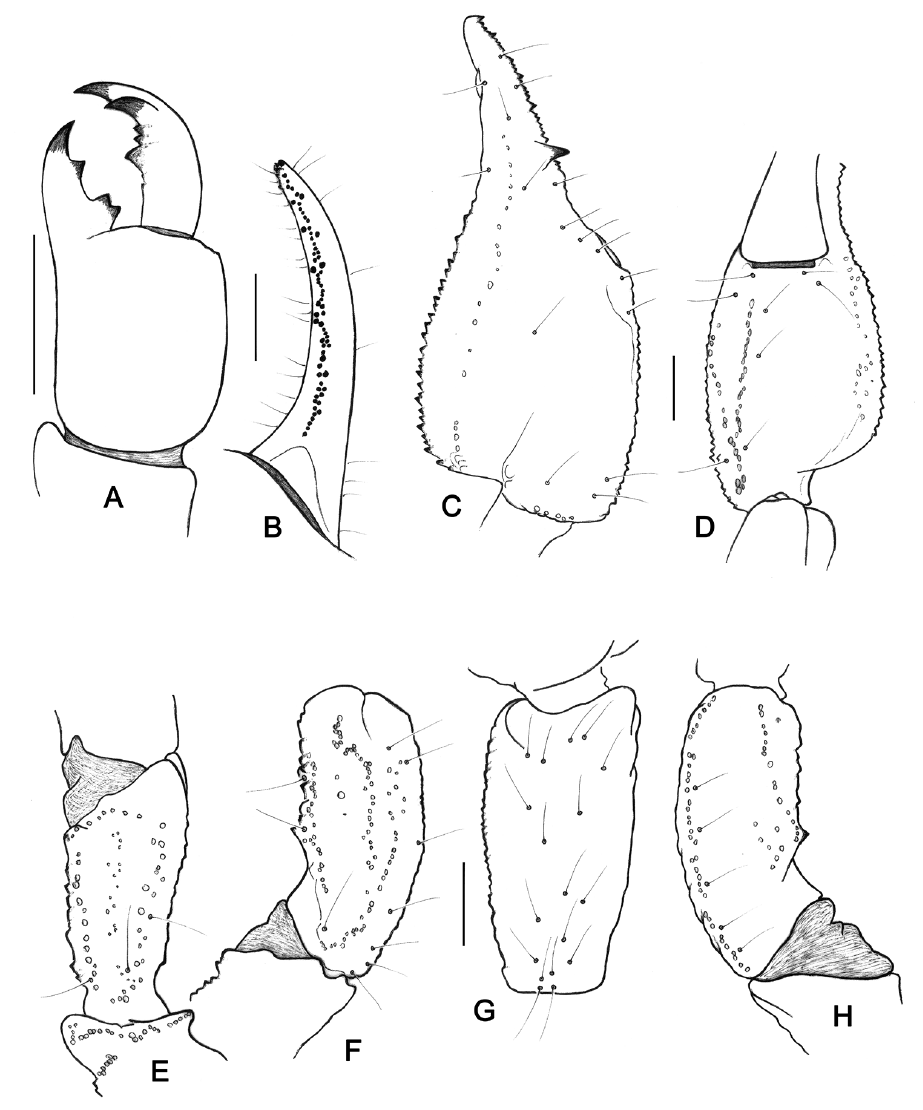
Figure 4. Teuthraustes khodayarii sp. n. Female holotype. A Chelicera, dorsal aspect B Disposition of the granulation over the dentate margins of pedipalp-chela movable finger C–H Trichobothrial pattern C–D Chela, dorso-external and ventral aspects E Femur, dorsal aspect F–H Patella, dorsal F external G and ventral H aspects. Scale bars 1 fingers dark red with teeth reddish yellow. Pedipalps: dark brown with blackish carinae; cutting edges of fingers reddish. Legs: reddish yellow to reddish brown without spots. Morphology. Prosoma: carapace intensely granulated, with a dense and thin granu- lation; furrows shallow; sternum pentagonal, wider than long. Mesosoma: tergites almost